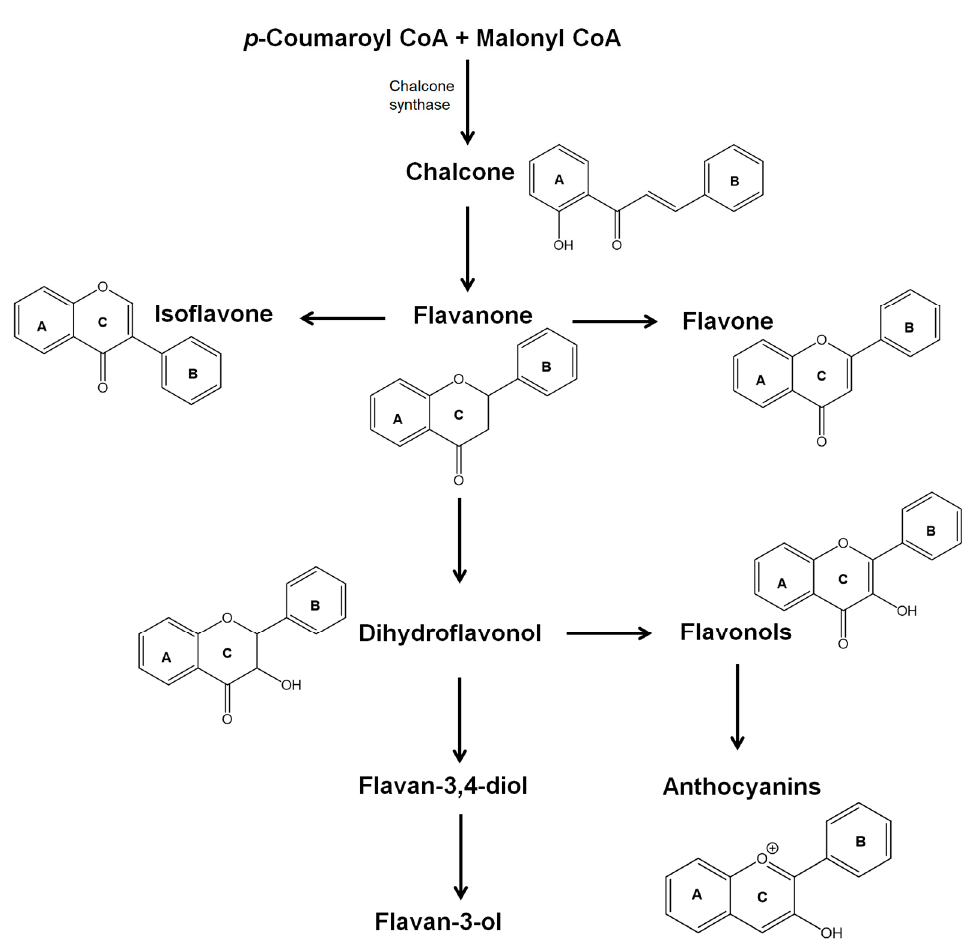
Figure 1. Flavonoid biosynthesis.